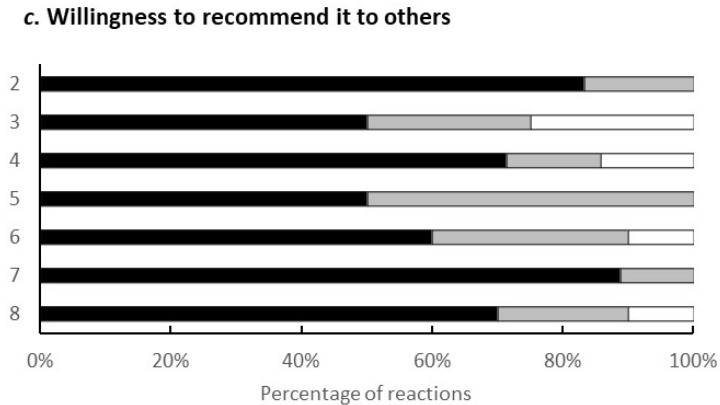
Figure A1. The vertical axis represents the number of times the workshop was held, and the horizontal axis represents the breakdown of respondents for each workshop. Black, grey and white bars exhibit 'strongly agree', 'agree' and 'neither’, respectively, to: ( a ), Satisfaction to the programme; ( b ), Intention to attend the next workshop; ( c ), Willingness to recommend the programme to others.